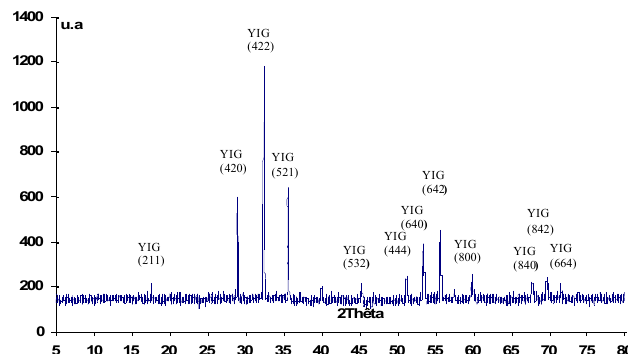
Figure 3: X-ray pattern of YIG film having a thickness of 12.4 μ m and annealed at 740 °C for 2 hours.